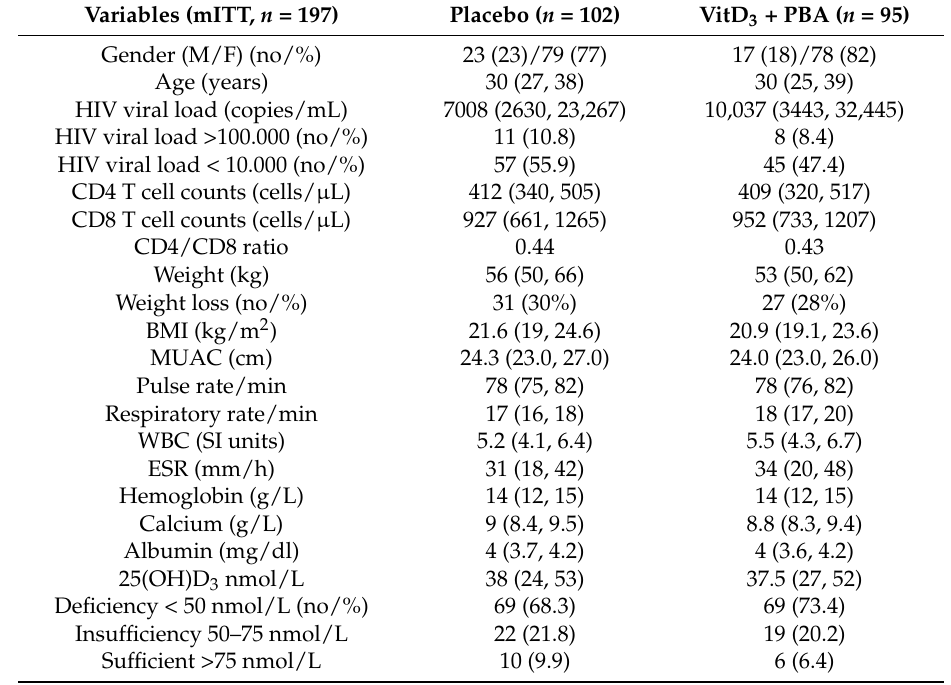
Table 2. Baseline characteristics in placebo versus vitD 3 +